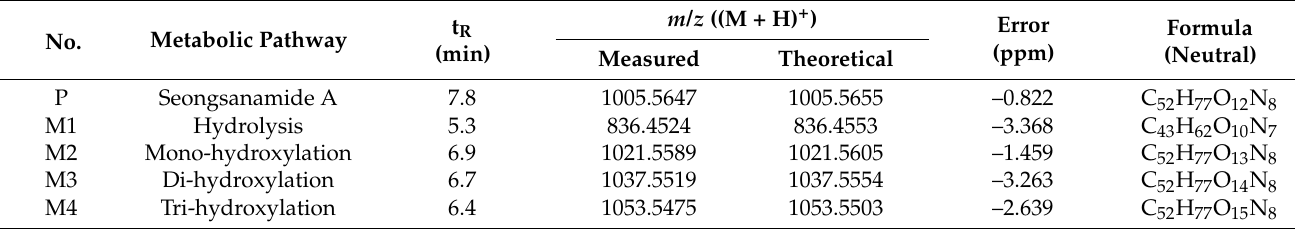
Table 1. Summary of the mass spectral data of seongsanamide A and its four metabolites identified in the human liver microsomal incubation